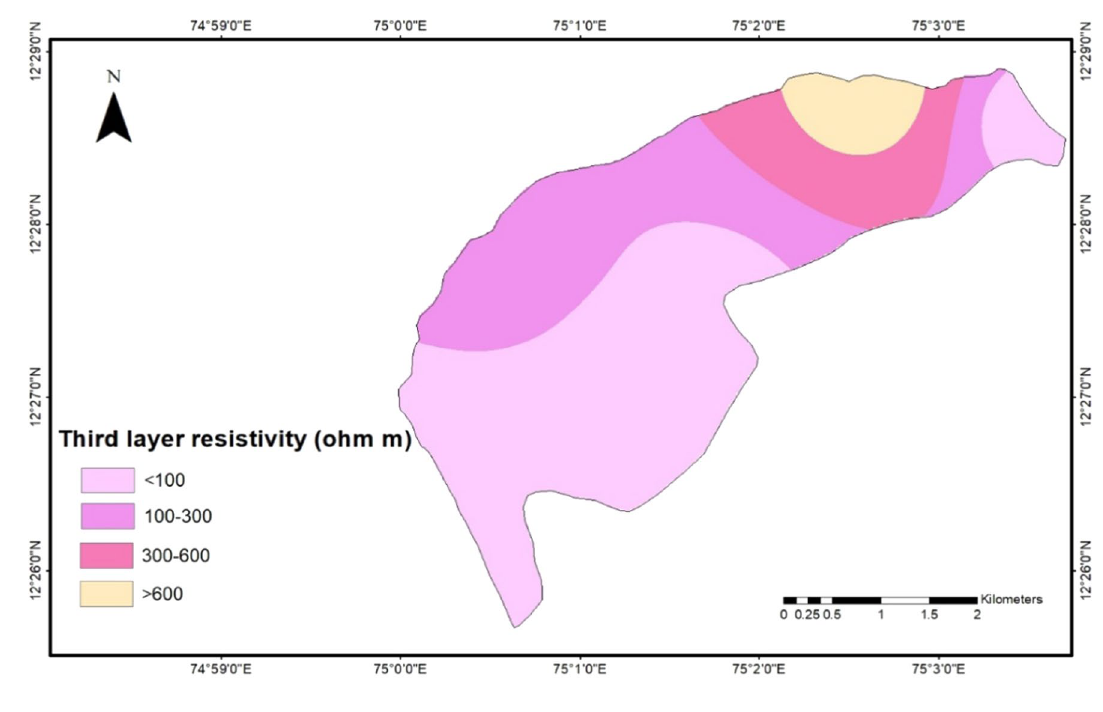
Fig. 8 Spatial variation map of third layer apparent resistivity(ohmm)